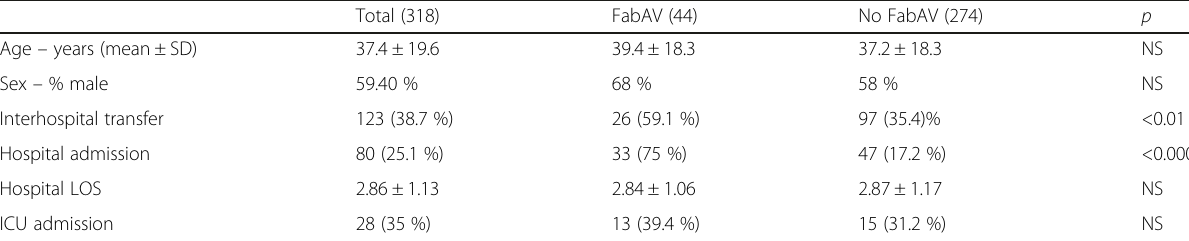
Table 1 Patient demographics